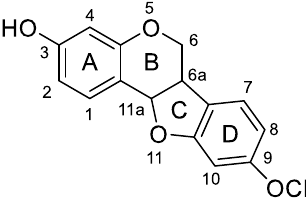
Figure 1. The structure and atom numbering of medicarpin.